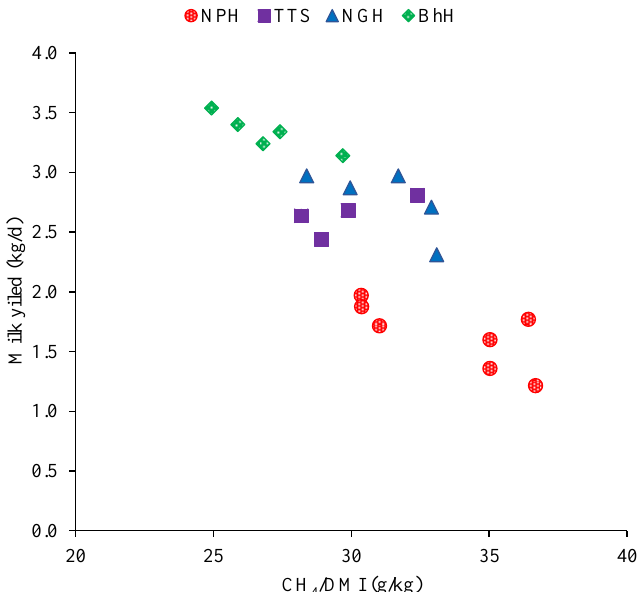
Figure 2. CH 4 emissions per dry matter intake (DMI) corresponding to daily milk yield ( R ² = 0.61). NPH, natural pasture hay; TTS, treated teff straw; NGH, Napier grass hay; BhH, Brachiaria hybrid grass hay.